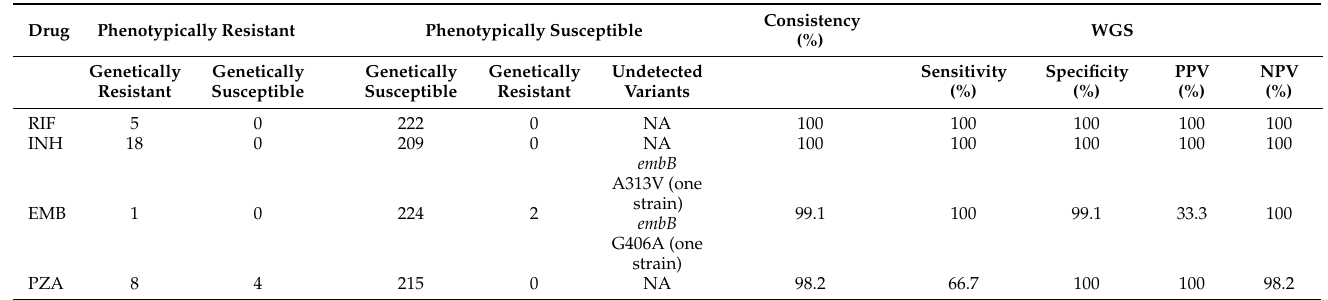
Table 1. Discrepancies between whole-genome sequencing (WGS) and phenotypic drug-susceptibility testing